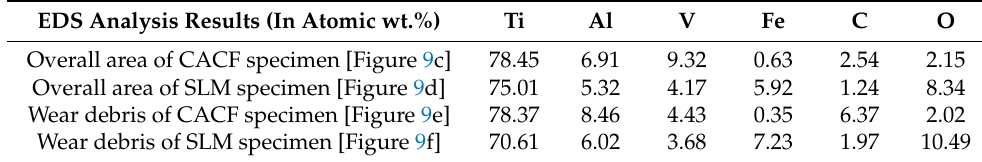
Table 3. EDS analysis results of worn out surface of CACF and SLM specimens. EDS Analysis Results (In Atomic